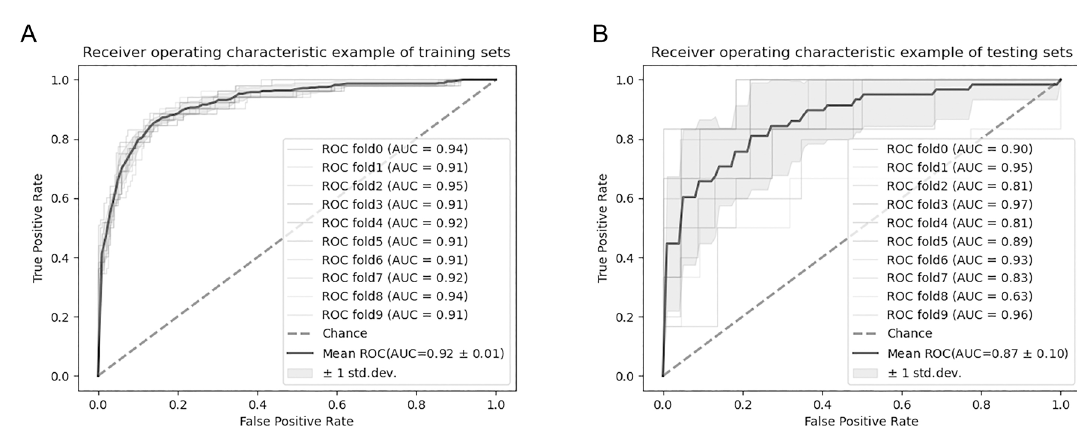
Figure 4. ( A ) ROC curves of 10 training sets, the mean AUC of 10 samples was 0.92 ± 0.01; ( B ) ROC curves of 10 validation sets, the mean AUC of 10 samples was 0.87 ± 0.10.